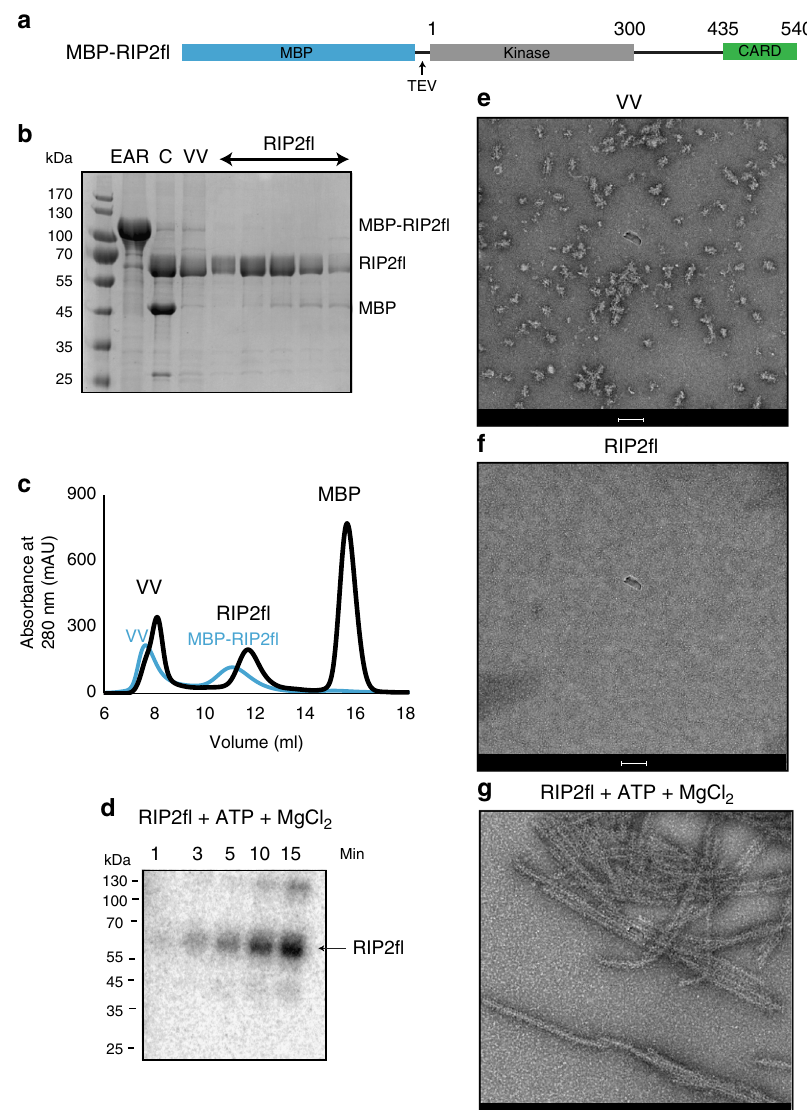
Fig. 1 Full-length RIP2 forms fi laments in vitro. a Domain organization of the MBP-RIP2 fl construct used for expression and puri fi cation of recombinant RIP2 fl from sf21 insect cells. b 12.5 % SDS-PAGE showing recombinant RIP2 fl at consecutive puri fi cations steps. c Typical size exclusion chromatography pro fi le for tagged (blue) and tag-free RIP2 fl (black). d In vitro kinase activity of RIP2 fl . Complete auto-phosphorylation is achieved after 15 min. e – g Negative-stain micrographs of ( e ) VV RIP2 fl , ( f ) RIP2 fl and ( g ) RIP2 fl with added ATP and magnesium chloride. Scale bars are 100 nm. EAR: eluate from amylose resin, C: sample after tag cleavage as loaded on size-exclusion chromatography, VV: size exclusion chromatography void volume, Min: